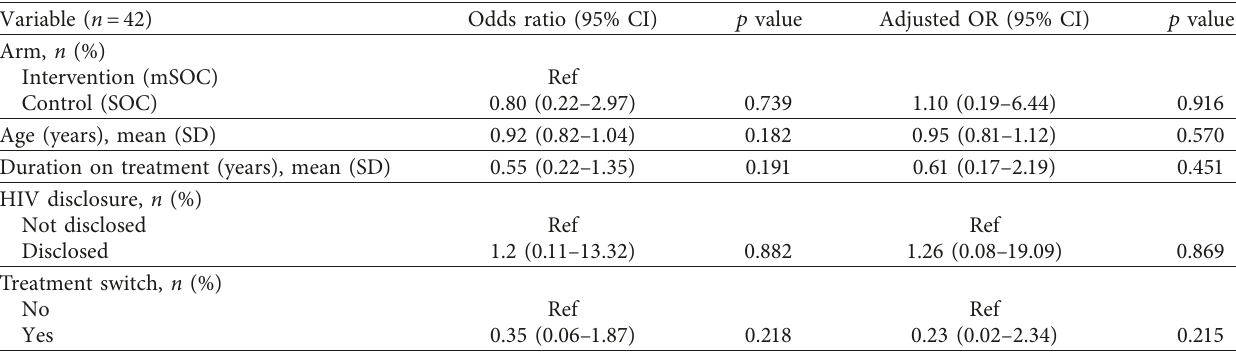
Table 3: Factors associated with viral suppression at 12 months.